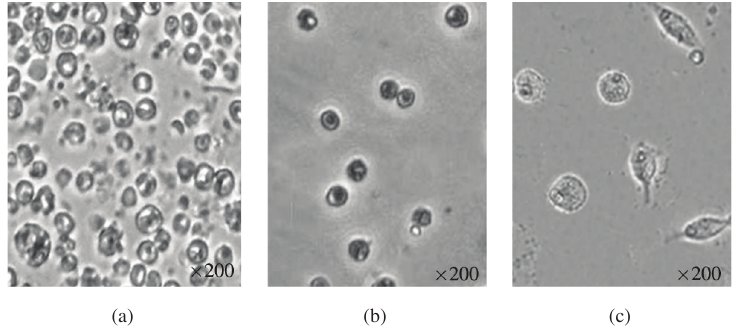
FIGURE 1: Morphology of mononucleated cells. Freshly isolated primary mononucleated cells (a). Both sus- pension mononucleated cells (b) and adherent mononucleated cells (c) were morphologically homoge-nous after 14 days in culture in complete medium ( × 200